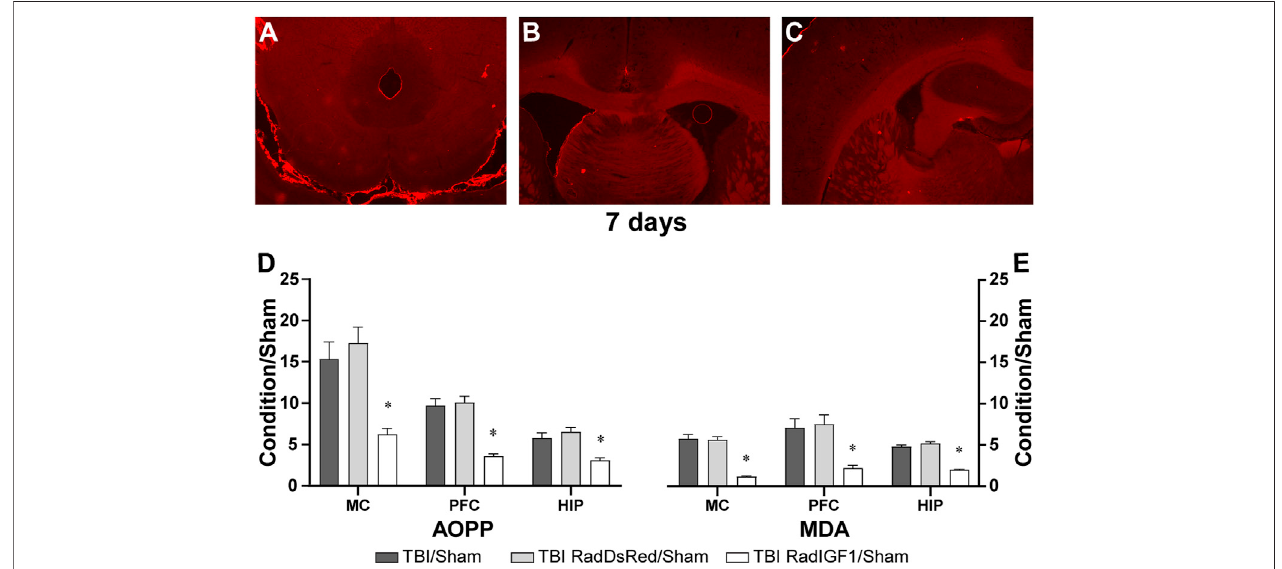
FIGURE 4 | Early IGF-1 treatment prevented TBI- induced OS biomarkers 7 days after injury. Microscopic photographs of brain areas showing expression of fl uorescent DsRed Protein. DsRed fl uorescence is more abundant in posterior brain slices, near the injection site (A) rather than anterior brain slices (B – C) . The graph shows the AOPP (D) and MDA (E) quanti fi cation as measurements of protein and lipid peroxidation, respectively, in brain areas neighboring the trauma area, such as Motorcortex(MC),Prefrontalcortex(PFC),andhippocampus(HIP).Resultsofpositivecontrol(TBI)andtreatedanimals(TBI+treatment),referredas “ condition ” in the Y axes, were normalized to negative controls (Sham). Bars represent the mean ± SEM; n (cid:2) 4 – 6. *Different from TBI/Sham and TBI RadDsRed/Sham in each brain structure ( p < 0.05).